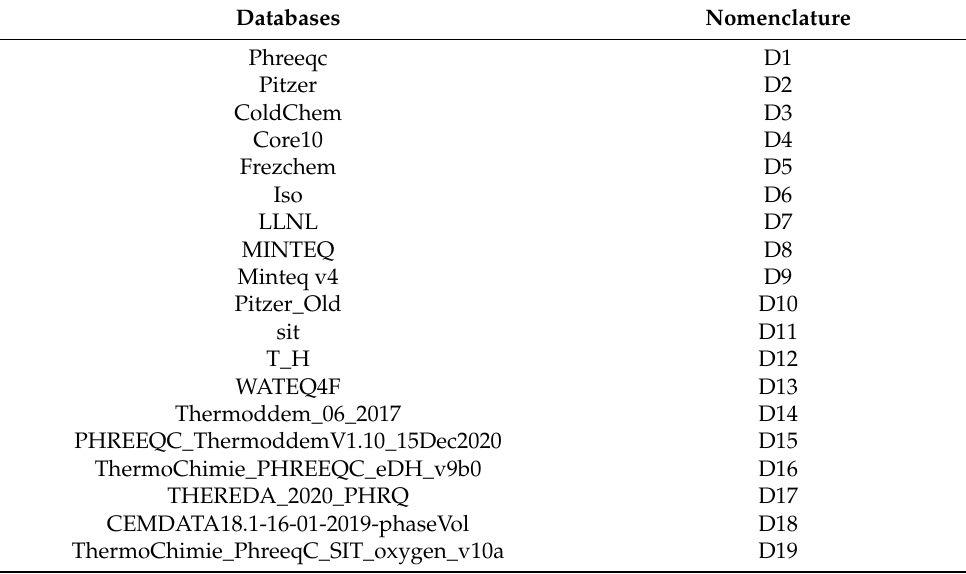
Table 4. PhreeqC databases and allocated